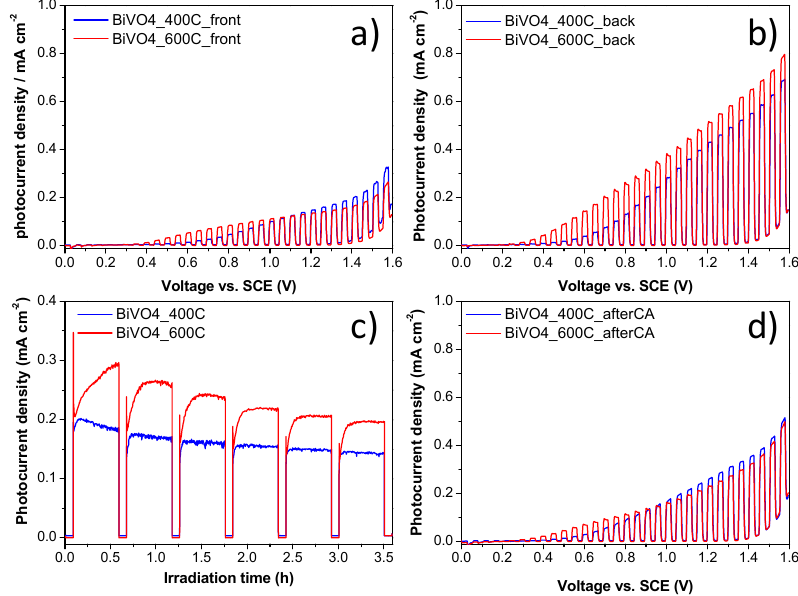
Figure 3. E ff ect of the post calcination temperature (400 or 600 ◦ C) of the BiVO 4 film on chopped Linear Sweep Voltammetry (LSV) curves under ( a ) front and ( b ) back irradiation of as-prepared samples; ( c ) chronoamperometry (CA) tests at 1.0 V vs. SCE; ( d ) chopped LSV curves under back irradiation recorded after CA tests (panel c ). All measurements were made in a 0.5 M Na 2 SO 4 electrolyte solution under simulated AM 1.5 G solar